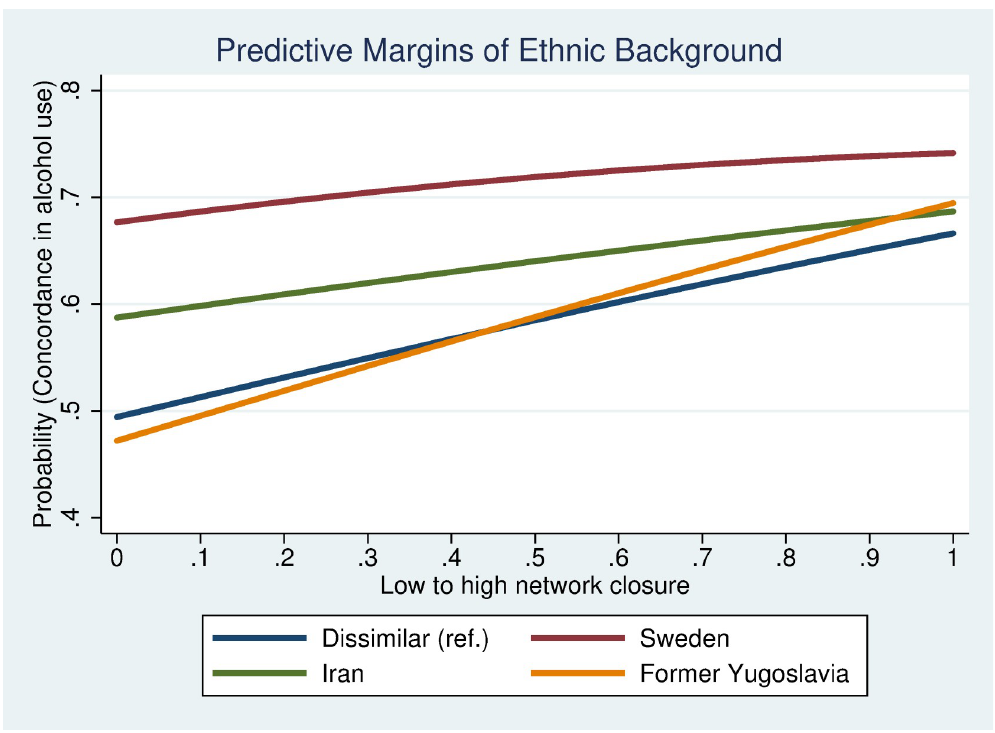
Fig 4. Concordance in alcohol habits by network